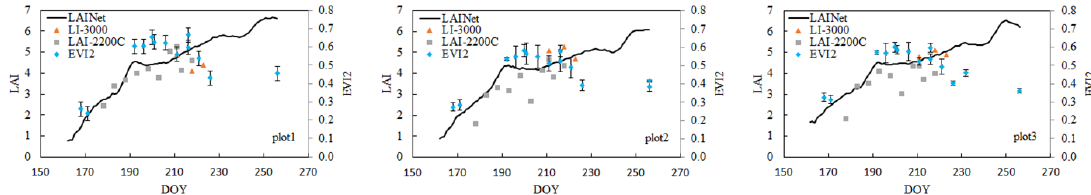
Figure 4. Temporal variation in field LAI measurements collected by LAINet, LAI-2200C, and LI-3000 at 3 corn plots in 2018. DOY stands for day of year.